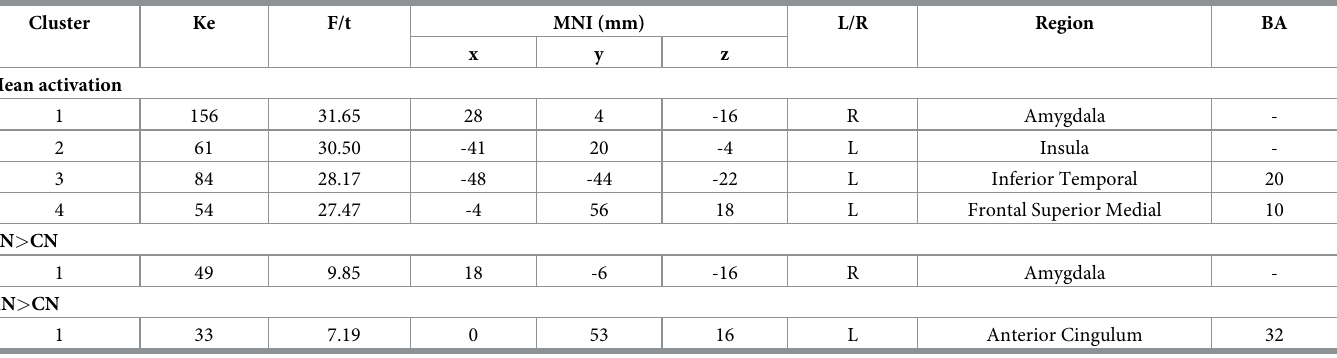
Table 4. Multi-voxel pattern analyses emotion